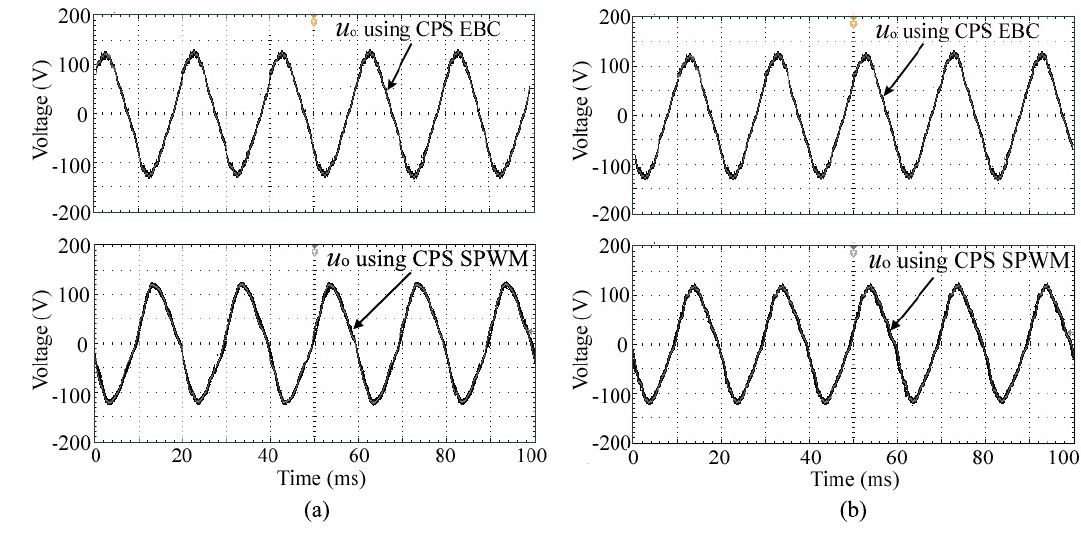
Figure 14. The experimental results of the five-level prototype under the case of DC voltages with fluctuations. ( a ) DC voltage u 1 contains a ripple with a frequency of 100 Hz and an amplitude of 16 V; and ( b ) DC voltage of each cascaded unit contains a frequency of 100 Hz and an amplitude of 8 V.